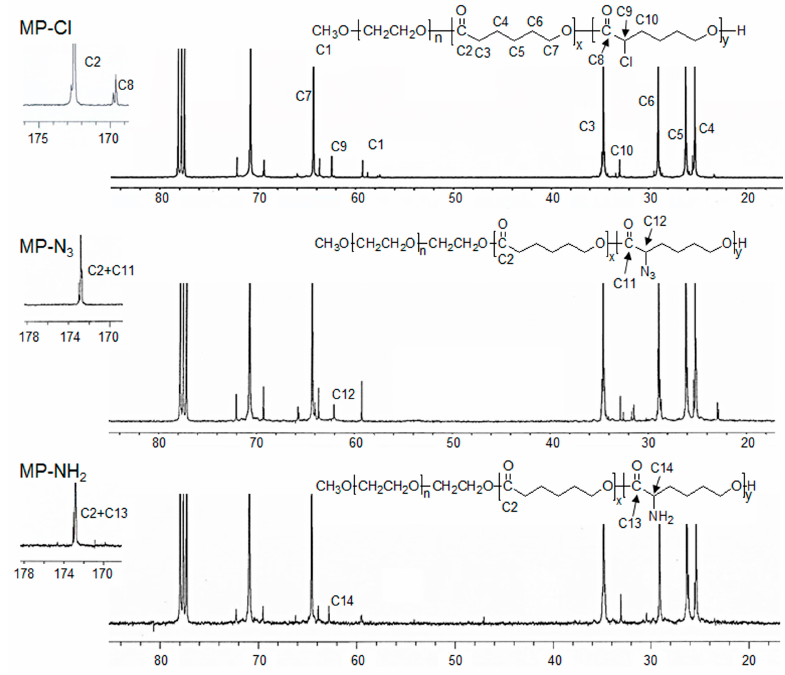
Figure 3 . 13 C-NMR spectra of MP-Cl, MP-N 3 and MP-NH 2 diblock copolymers. Figure 3. 13 C-NMR spectra of MP-Cl, MP-N 3 and MP-NH 2 diblock